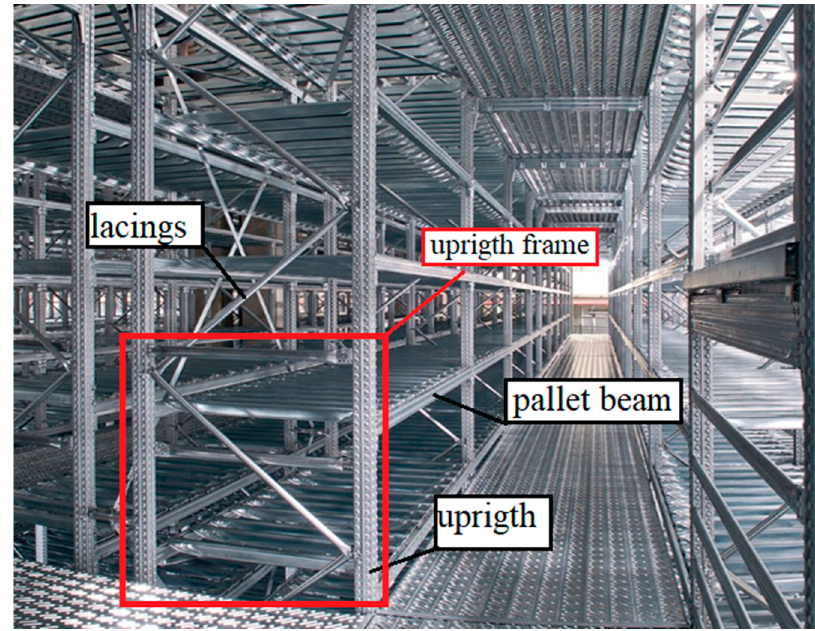
Figure 1. A typical steel rack with its main components.